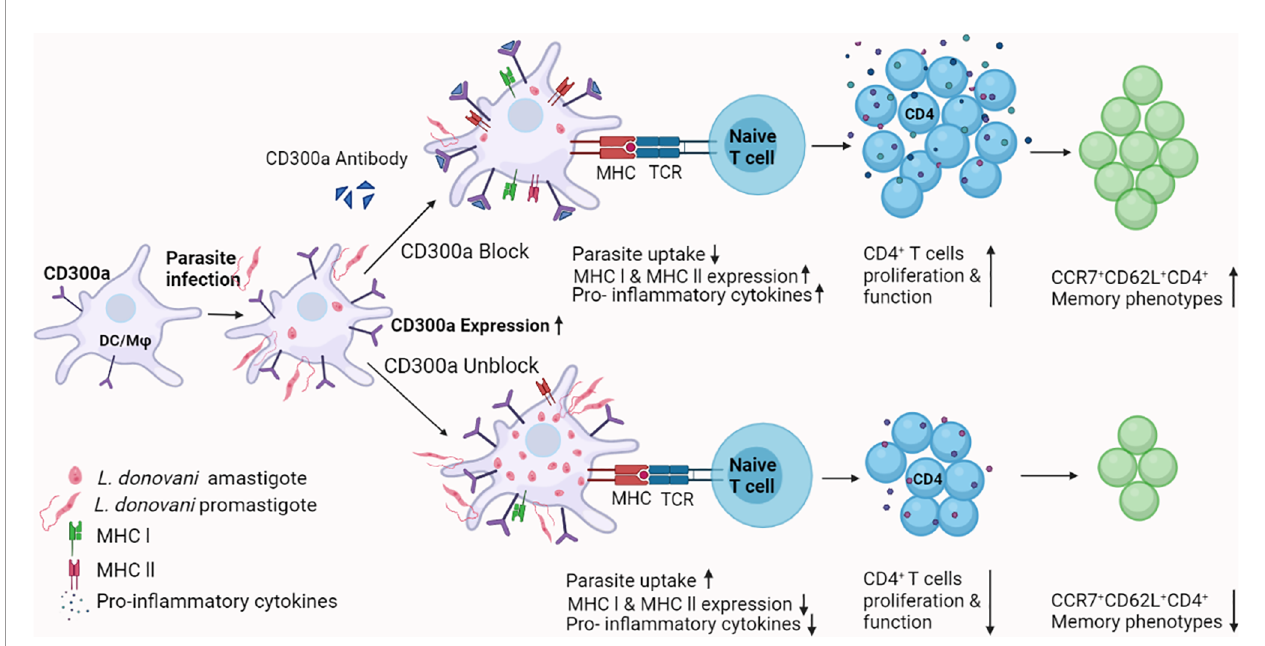
FIGURE 7 | A schematic model for the role of CD300a receptor in parasitic infectivity, APCs and T cells effector functions, and memory generation during Leishmania infection. Based on observations made in the current study, it may be surmised that the parasite induces CD300a receptors on the host ’ s phagocytic and antigen presenting cells to counter the defense machinery, which eventually facilitates the survival of parasites. The blocking of CD300a receptors increases APCs function and promotes antigen speci fi c T cells activation and differentiation required to establish early protective immunity. Thus, strategies involving CD300a receptor manipulation may prove advantageous to curb the survival of Leishmania in their mammalian host and also can boost antigen-speci fi c immune